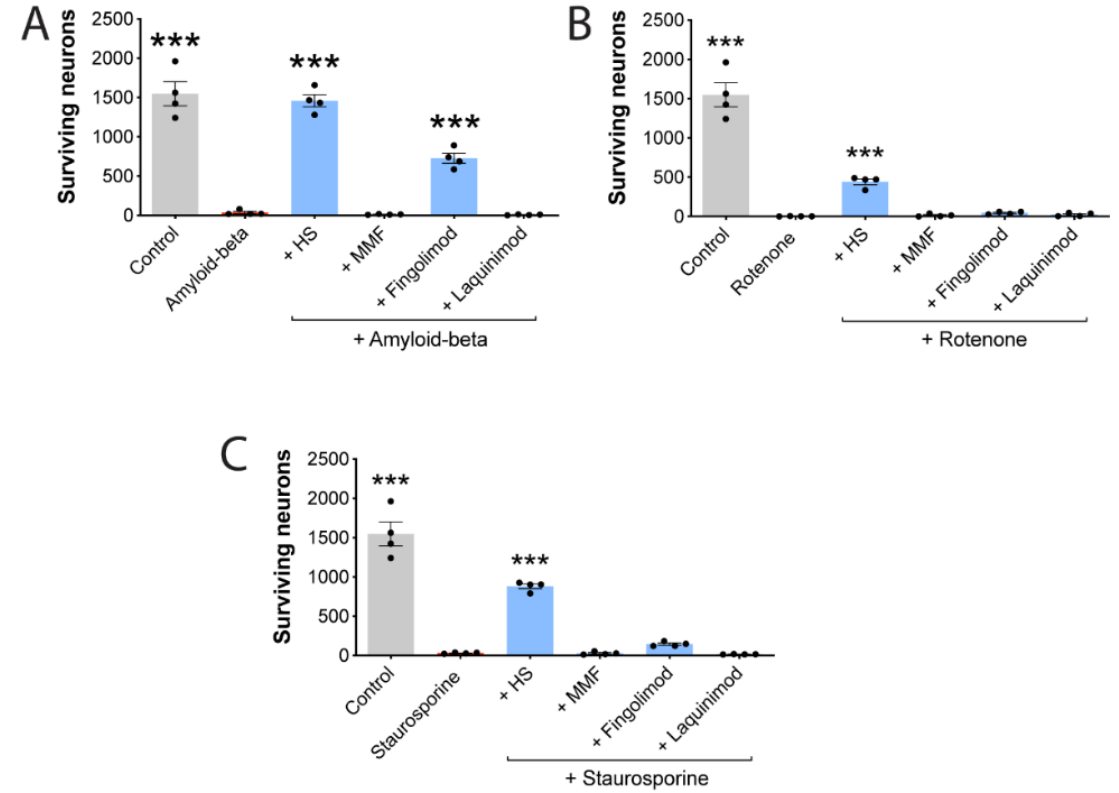
Figure 4. HS protects against other mediators of injury. Neurons were exposed to HS and the test medications for 1 h prior to amyloid-beta (20 μ M) ( A ), rotenone (10 μ M) ( B ) or staurosporine (200 nM) ( C ). Cells were harvested 24 h after for neuronal counts. HS was used at 100 µ g/mL, while MMF was tested at 100 µ M, fingolimod (FTY-720P) at 100 nM and laquinimod at 5 µ M. All values are mean ± SEM, with each dot representing a well. *** p < 0.001 compared to the toxins alone (1-way ANOVA with Dunnett multiple comparisons).